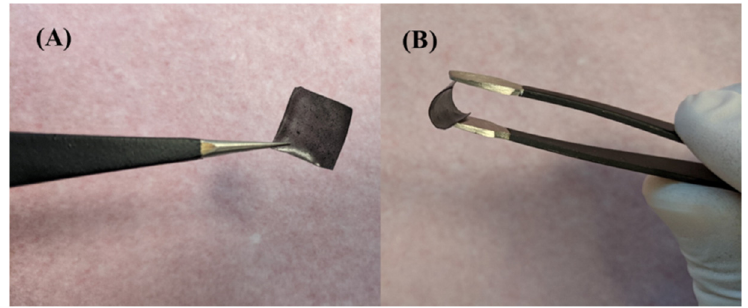
Figure 1. ( A ) A typical 1 × 1 cm 2 Cu-MOF / PVA / IL membrane, ( B ) A demonstration of the high- flexibility of the membrane.